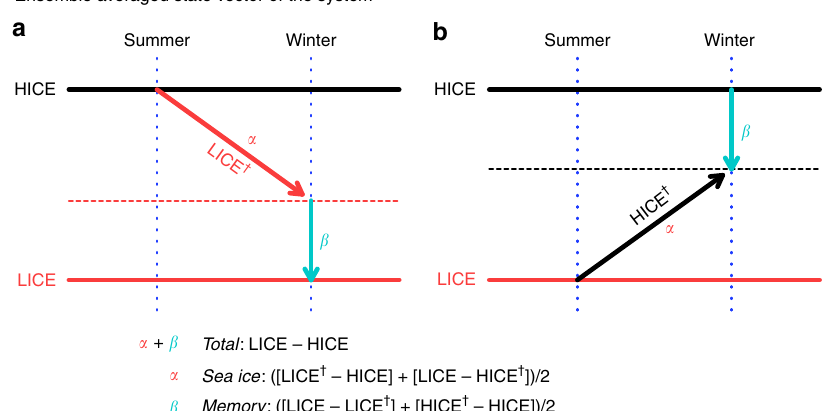
Fig. 1 A schematic diagram of the experimental design to estimate the memory effect. Hundred-year averaged state vectors of the system. Systems with the same initial condition but different boundary conditions of high and low ice years immediately separate and become stable around individual states suitable for high and low ice conditions. Here, these states are de fi ned as HICE and LICE, and indicated by black and red solid lines, respectively. a A state with a low ice condition initialized by atmospheric and land conditions existing on 1 July during HICE integration will tend to converge to the LICE state. However, during development of the atmospheric state from one summer to the next winter timeframe, it will only reach an intermediate state. This state is de fi ned as LICE † , indicated by red arrow. The estimated memory effect is de fi ned as the residuals of the LICE and LICE † states. b Similarly, a state with a high ice condition initialized by LICE will reach another state de fi ned as HICE † and indicated by black arrow. The averages of the estimated values from both LICE † and HICE † were used for analyses according to the formulations shown under the panels (see the Methods section)